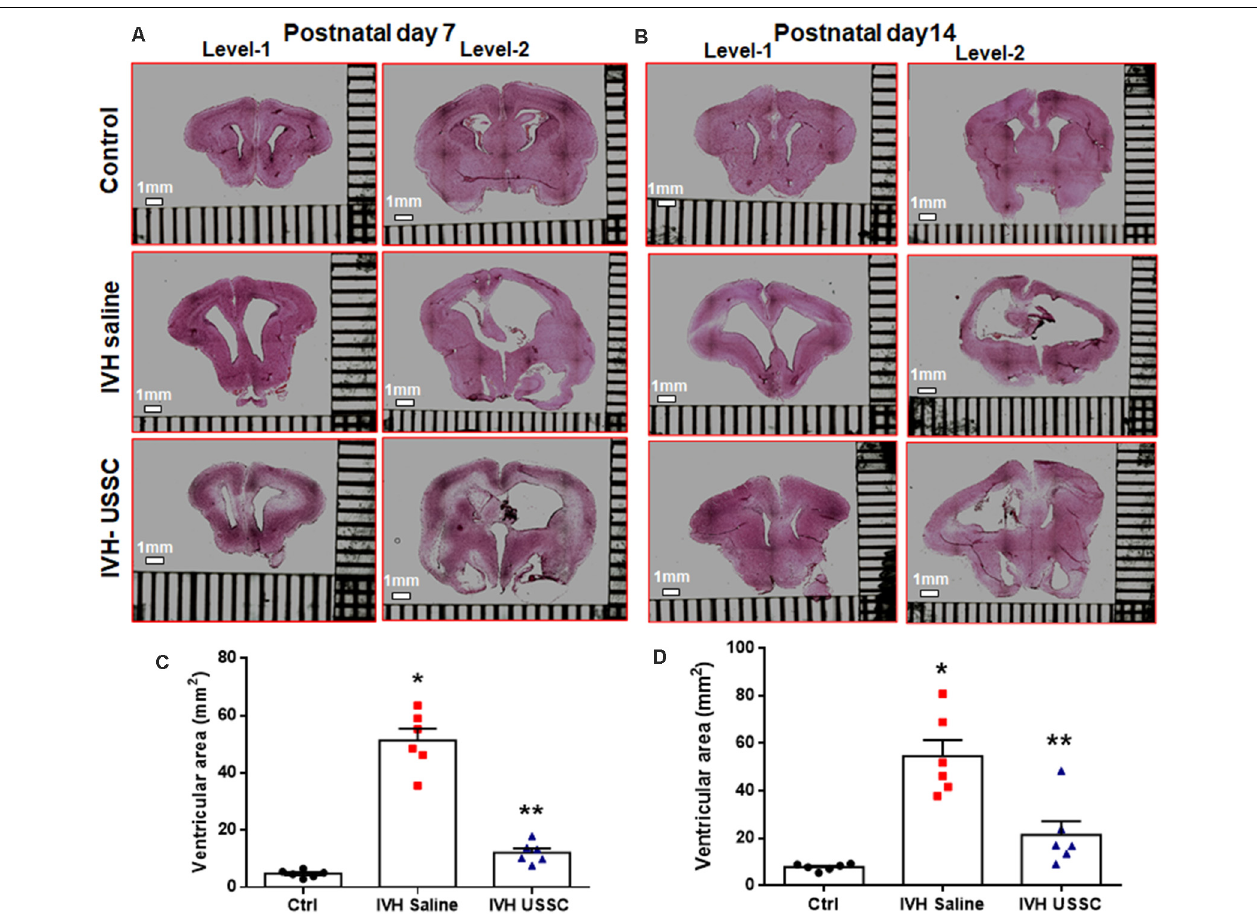
FIGURE 1 | Intracerebroventricular unrestricted somatic stem cells (USSC) administration reduced cross sectional area of lateral ventricles in post-hemorrhagic hydrocephalus (PHH). (A) Representative Hematoxylin and Eosin (H&E) stained coronal section on postnatal day 7 at two levels (rostral forebrain: level-1 and caudal forebrain: level-2) with and without USSC administration, showing ventricular size in normal healthy control, intraventricular hemorrhage (IVH) saline control and single dose USSC (2 × 10 6 cells/dose) injected (left panel A ). (B) Ventricular area on postnatal day 14 in normal healthy control, IVH saline control and single dose USSC (2 × 10 6 cells/dose) injected (right panel B ). The stitched images are taken at low power for both postnatal ages from 20 µ m sections. The scale bar in all images is 1 mm. Images were scanned using EVOS (cid:114) FL Auto Imaging System (Thermo Fisher Scientific, Waltham, MA, USA). (C,D) Scatter plots with bar graphs showing cross-sectional area of lateral ventricles measurement on postnatal day 7 (C) and 14 (D) . The mean cross sectional measured on two alternate sections taken from hippocampus towards the rostral side of the coronal block made at the level of mid-septal nucleus (total ventricular area is the sum of the left and right values at level-2 that are averaged from two alternate section for each pup). Each symbol in the experimental groups represent one rabbit pup (* P < 0.05 for control vs. IVH and ** P < 0.05 for IVH vs. USSCs; the values represent mean ± SEM; n = 6 in each group for both postnatal days 7 and 14). P -values were derived by one-way ANOVA with Tukey’s multiple comparisons